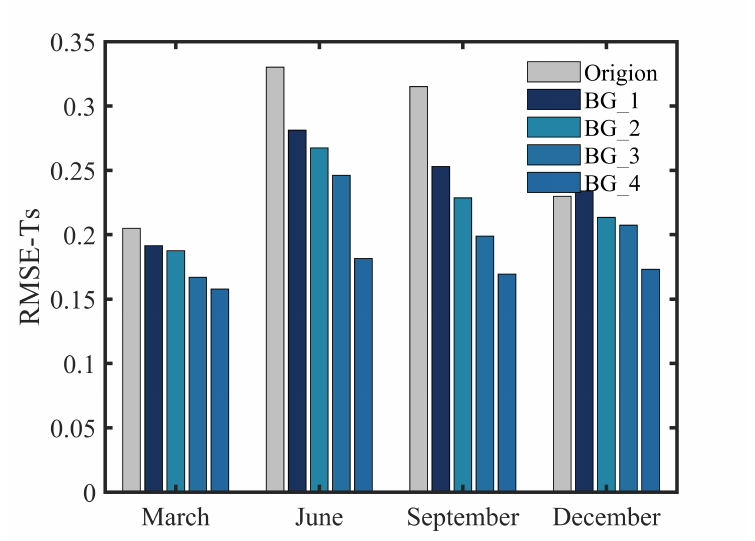
Figure 4. The mean of the RMSE series analysis introduced different observation position sets in four